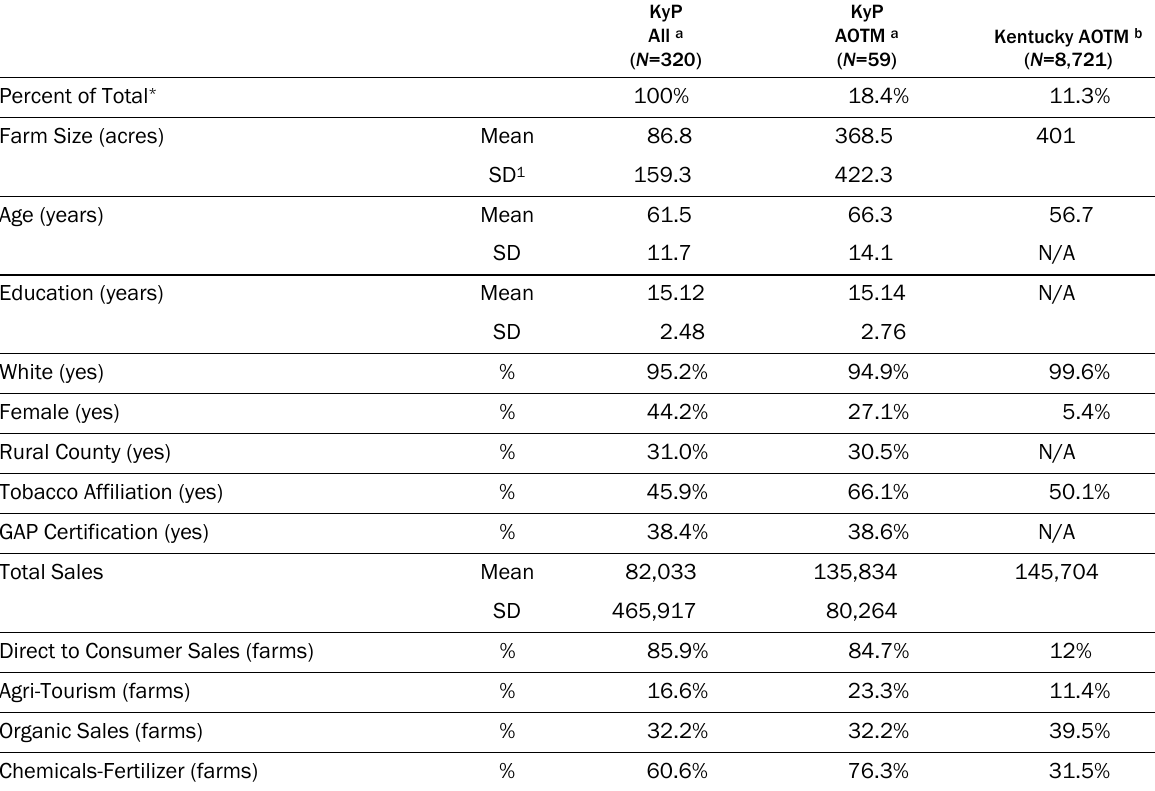
Table 3 . Key Characteristics of the 2011 Kentucky Proud (KyP) Survey Participants ( N =320), in Comparison to Kentucky AOTM Farmers in the 2012 U.S. Census of